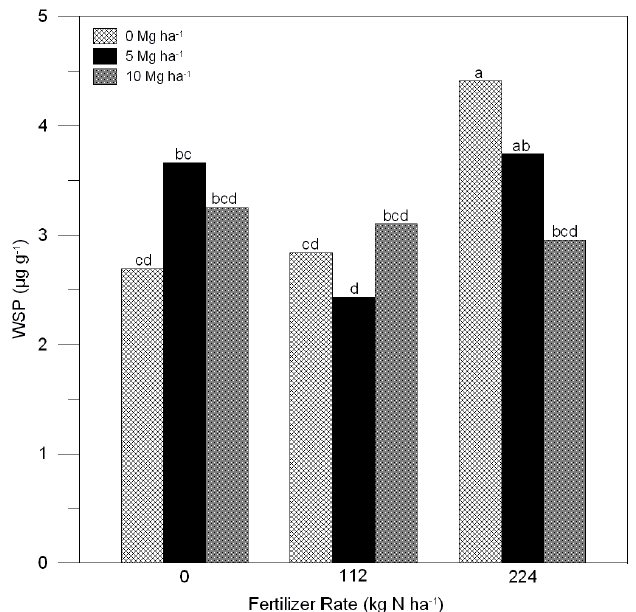
Figure 2. Water soluble phosphorus (WSP) concentrations as influenced by pine woodchip biochar and fertilizer rates. The fertilizer rates are 0, 112, and 224 kg·nitrogen (N)·ha − 1 rates. The biochar treatments are displayed in the shaded boxes at rates of 0, 5, and 10 Mg·ha − 1 . Bars with different letters are statistically different from each other ( p < 0.05).